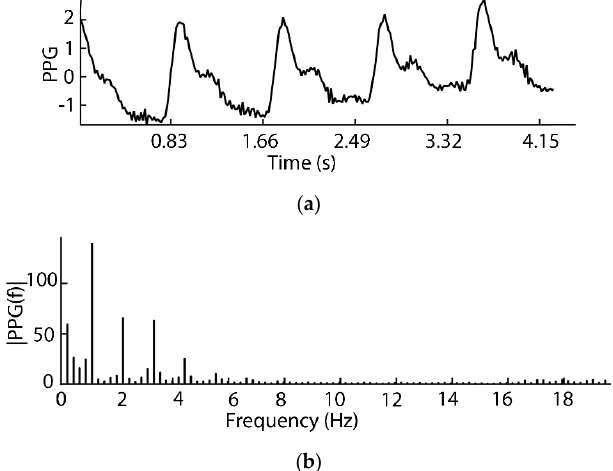
Figure 5. ( a ) Normalized PPG signal in SPW and ( b ) its spectrum. Figure 6. The block diagram of signal fast Fourier transform (FFT) filtering algorithm.